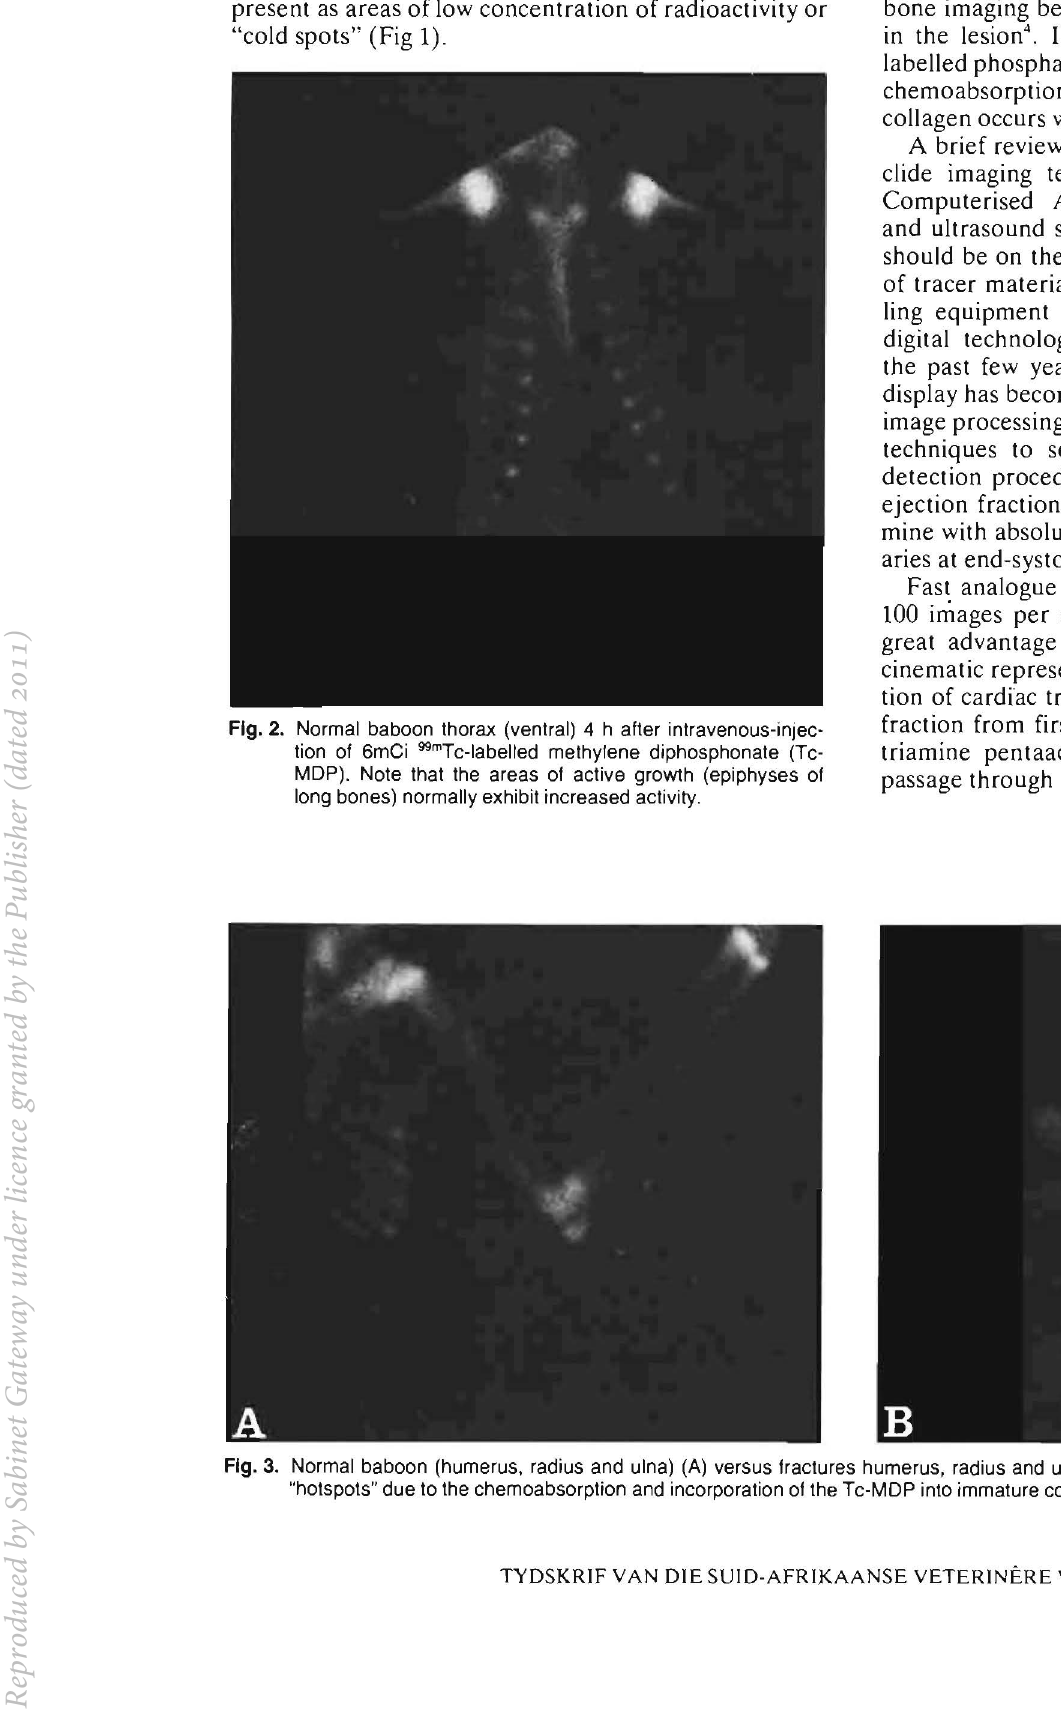
TYDSKRIF VAN DIE SUIO-AFRIKAANSE VETERINERE